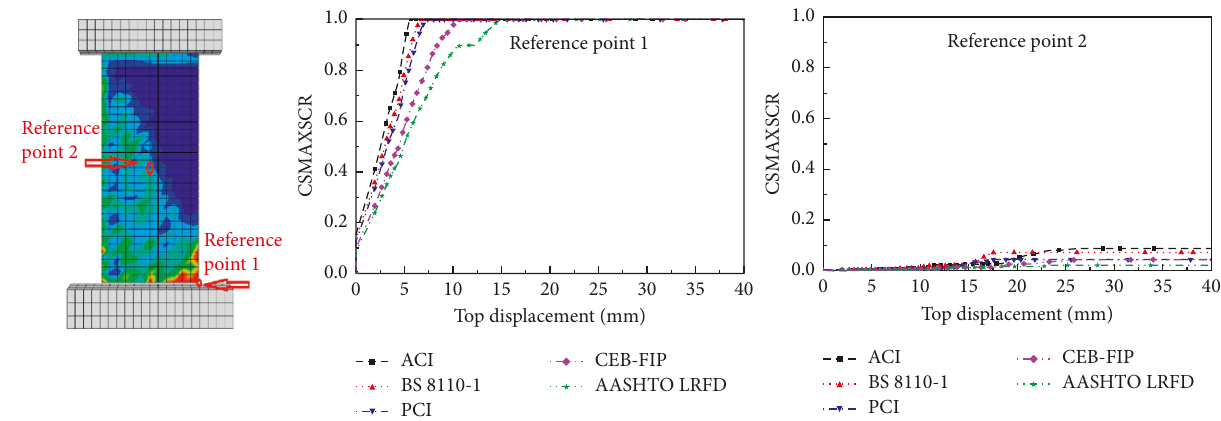
Figure 23: CSMAXSCR-top displacement curves of W3 under 0.3 axial compression ratio. Table 6: Comparison of the ultimate bearing capacity based on different design codes under 0.5 axial compression ratio. Design code